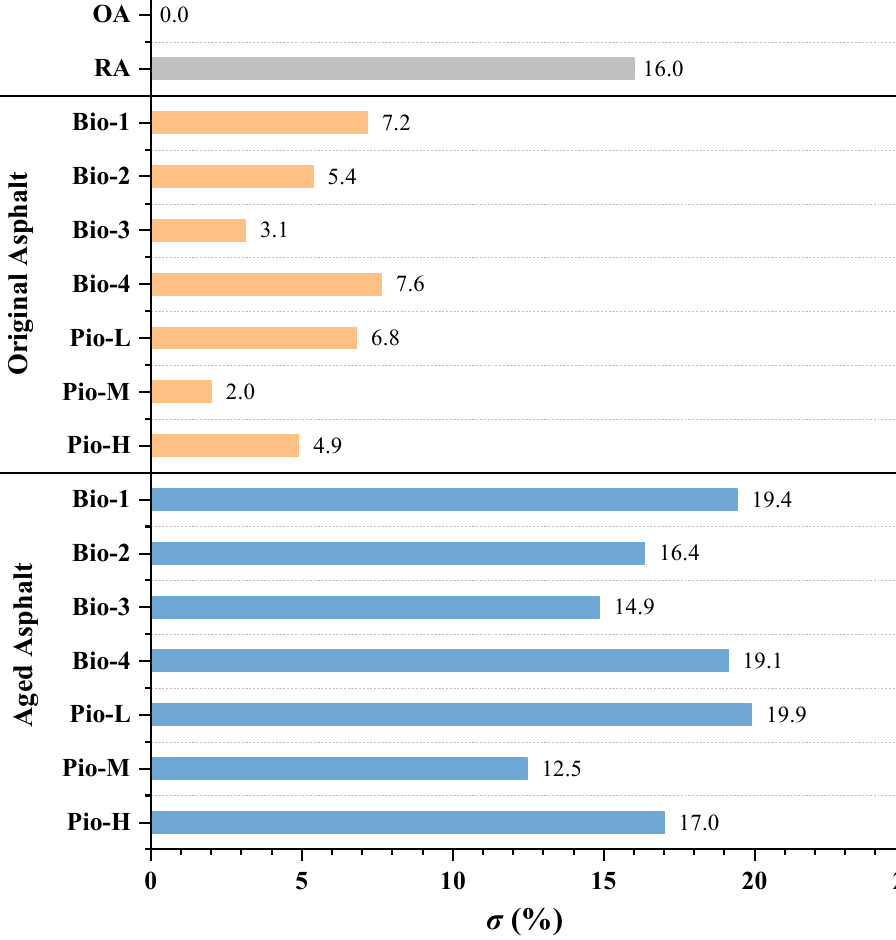
Figure 6. σ value of all the asphalt samples.